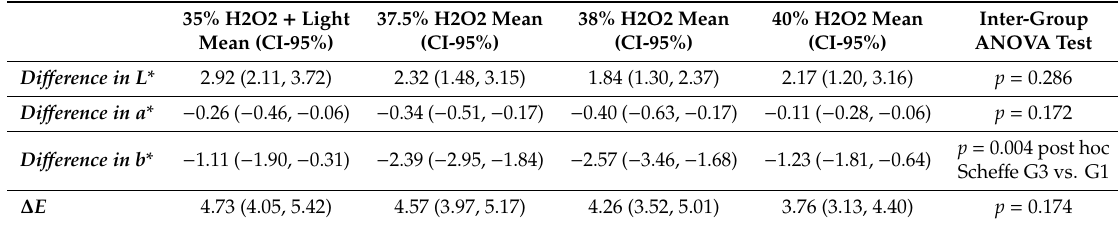
Table 2. Di ff erences in mean L*, a*, and b* parameters and ∆ E from initial to final